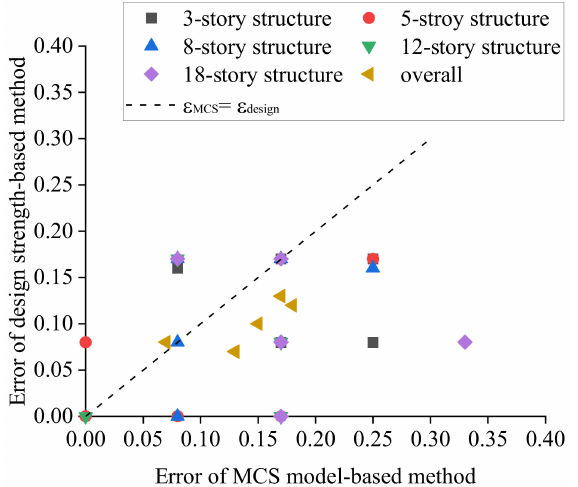
Figure 8. Error of the design-strength-based method and the MCS model with THA, taking the results of the refined FE model with THA as true